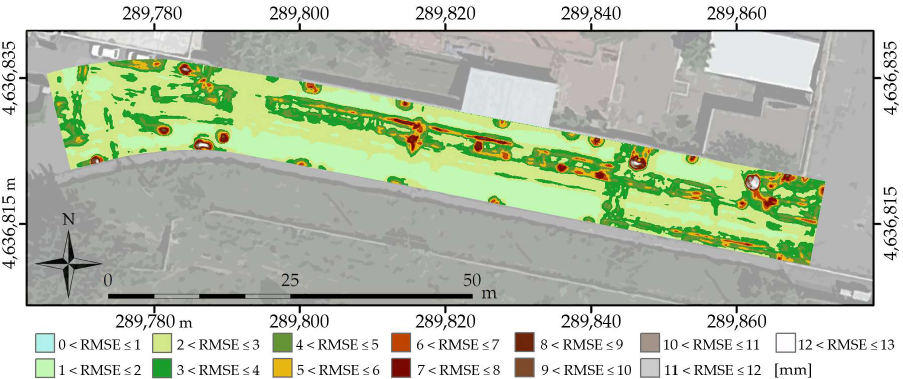
Figure 13. Estimation of the accuracy of the points fitting to the plane; the computed values of Root Mean Square Error (RMSE) are associated with the points.